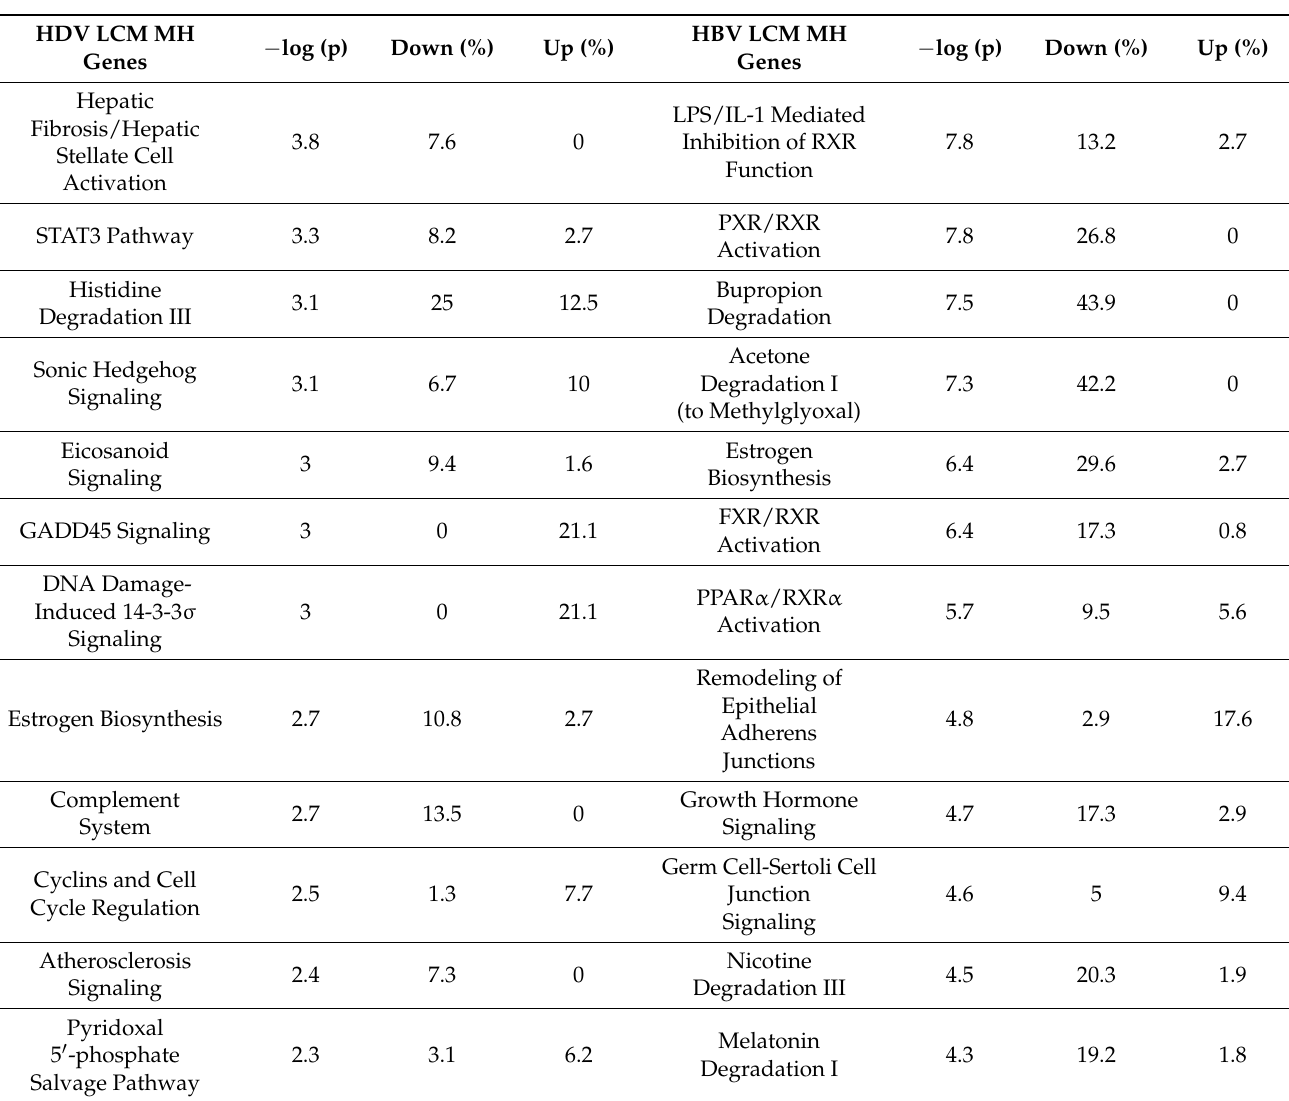
Table 1. Comparison of the top-ranked canonical pathways of genes differentially expressed in malignant hepatocytes (MH) using laser-capture microdissection (LCM) between HDV-HCC and HBV-HCC. For each pathway, -log(p) is the statistical significance expressed as the negative log of the P value of Fisher exact test; down (%) and up (%) are the percent ratio between the number of downregulated and upregulated genes present in the dataset and the total number of genes present in the database of Ingenuity Canonical Pathways [42]. The red boxes indicate the four common pathways between HDV-HCC and